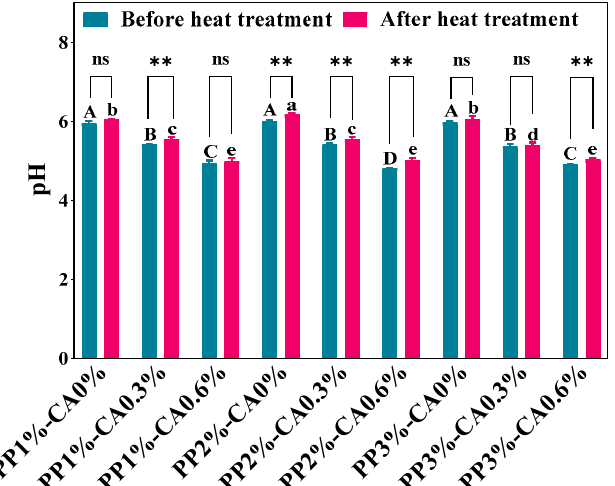
Figure 6. The pH of the mackerel mince before and after heat treatment. The letters “A–D” represent the significance between mackerel mince before heat treatment; the letters “a–e” indicate the significance between mackerel mince after heat treatment ( p < 0.05). The asterisks (**) indicate the significant differences between the two groups before and after heat treatment at p < 0.01; the mark (ns) indicates no significant difference between two groups before and after heat treatment ( p ≥ 0.05).